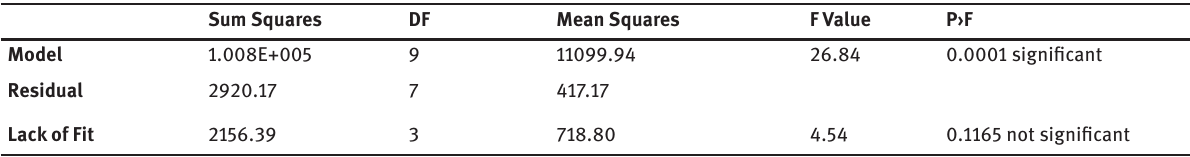
Fig ure 2: 3-D graph showing the total polyphenol content in the green tea extracts a) solid / liquid ratio and variation with time, b) temperature and variation with time, c) temperature and variation with solid/liquid ratio. Table 4 : Analysis of varience (ANOVA) for fitted quadratic polynomial model of polyphenol amount in green